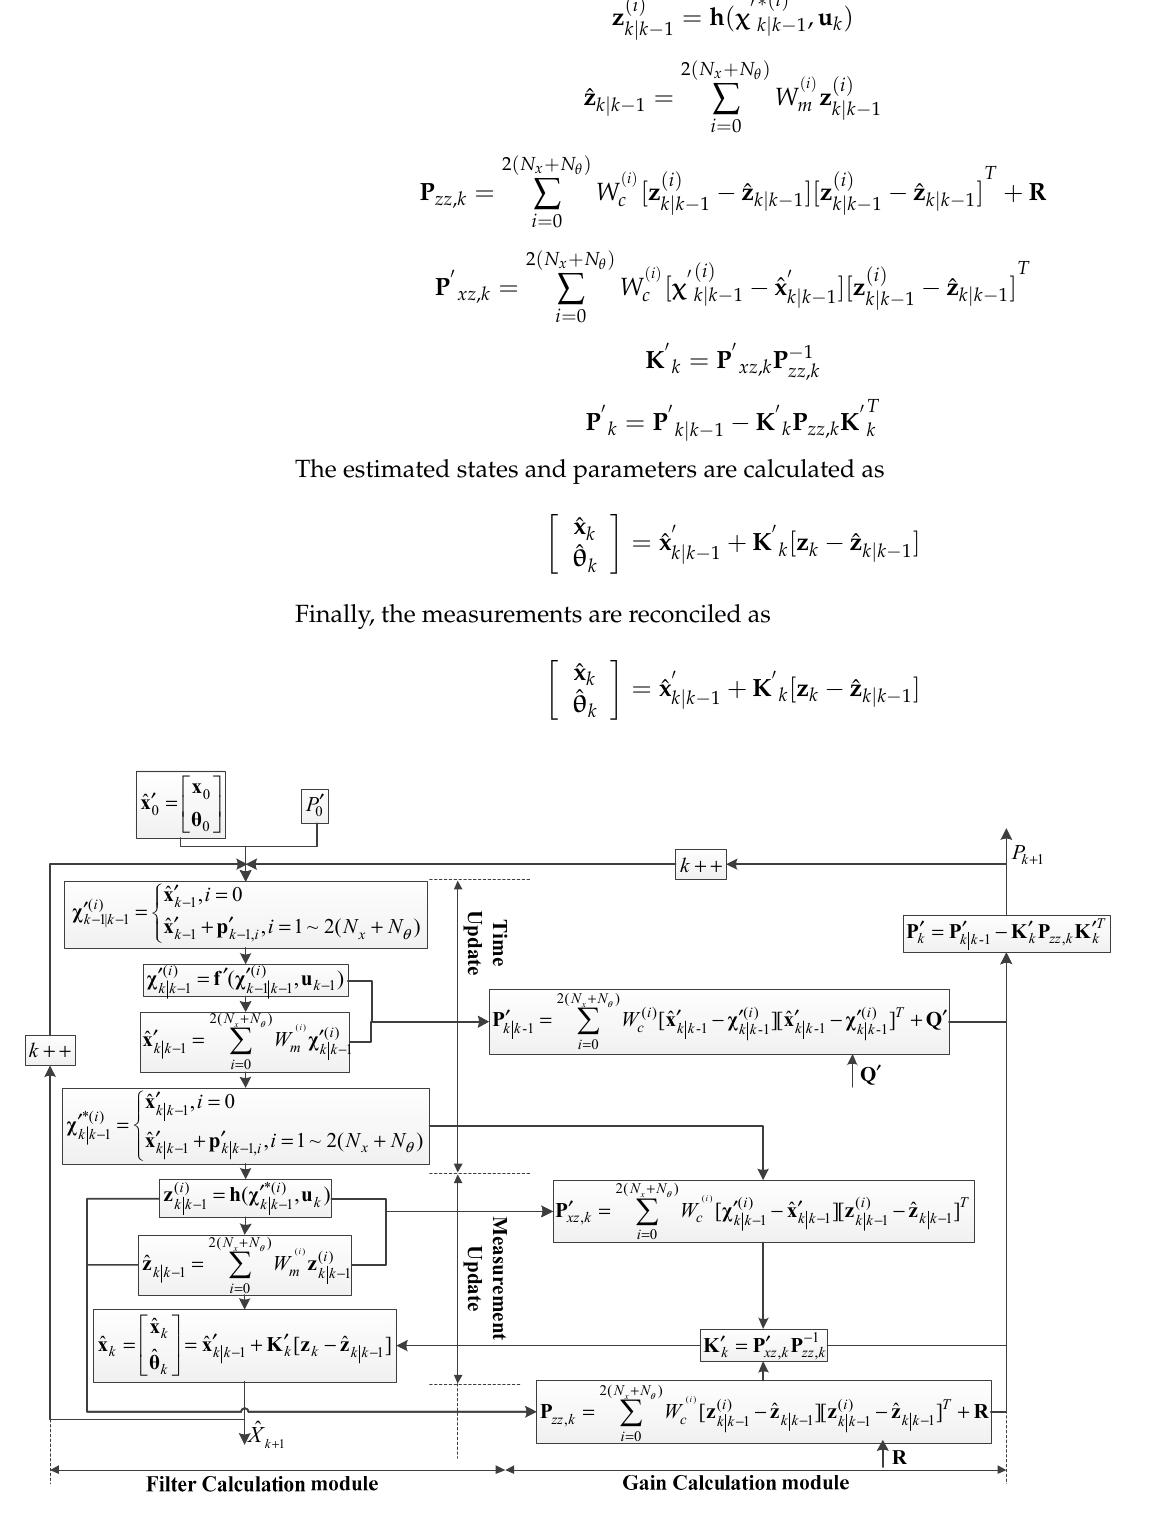
Figure 2. The process of UKF-based SPE.